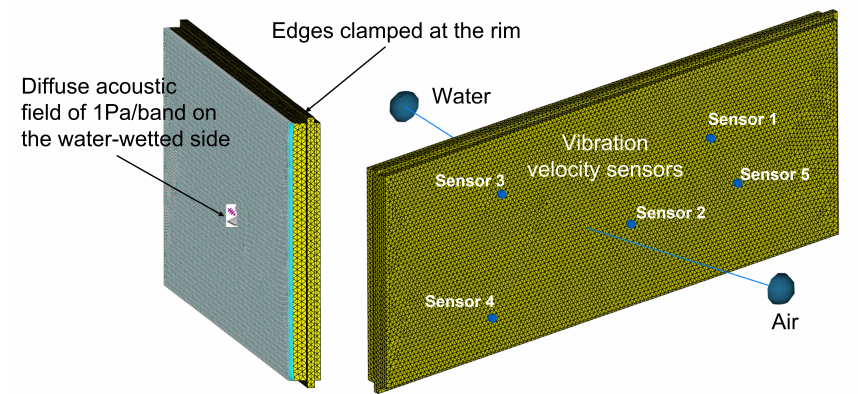
Figure 8. FEM model of the cavitation tunnel window and sensor placements.